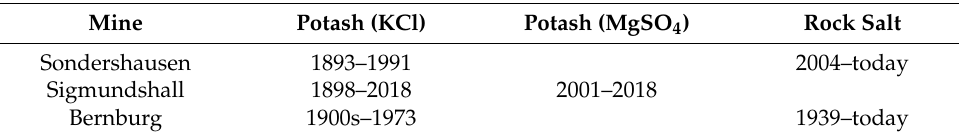
Table 1. Potash and salt production history in German mines. Mine Potash (KCl) Potash (MgSO 4 ) Rock Salt